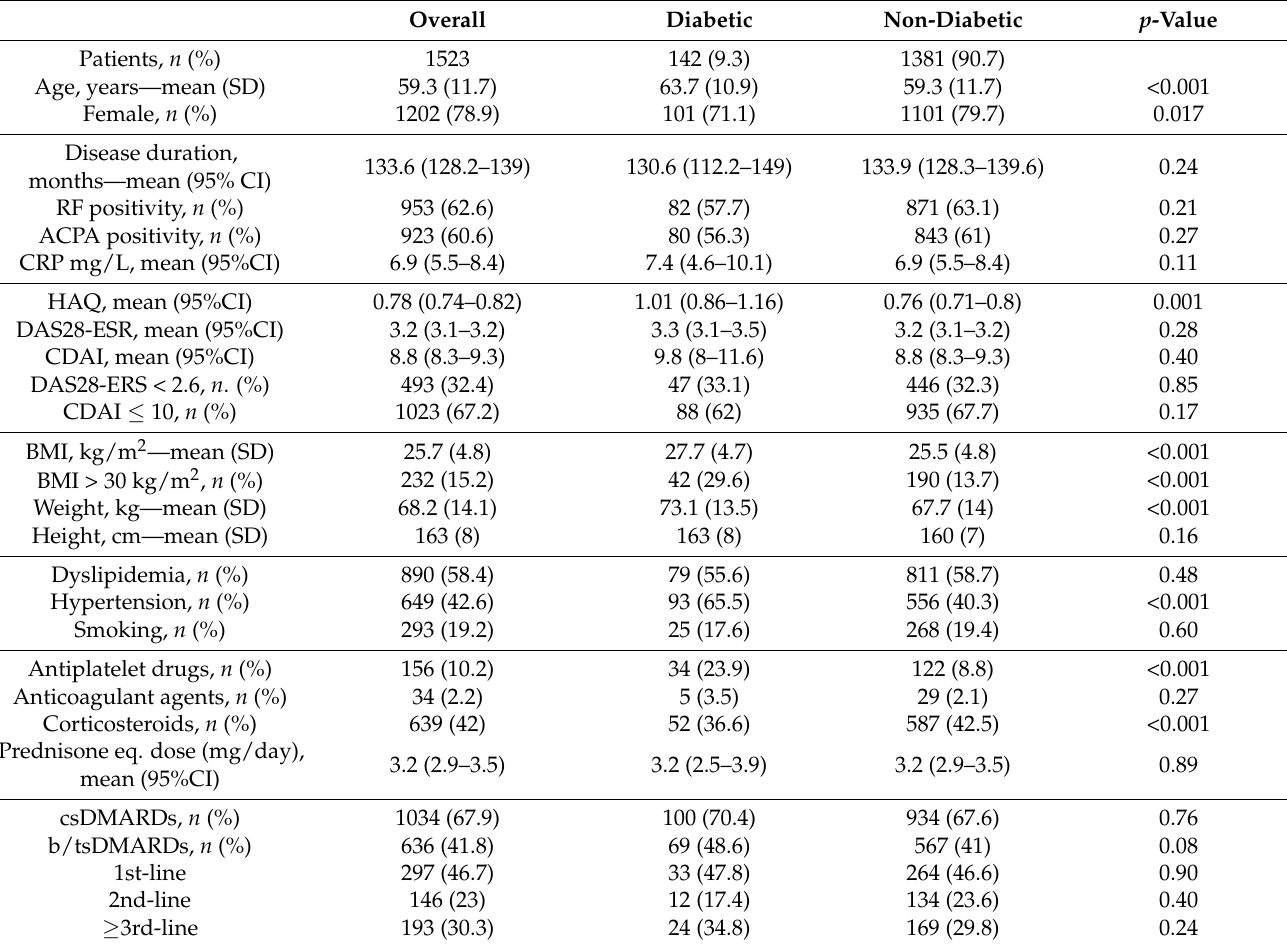
Table 1. Demographic and clinical features of RA patients.